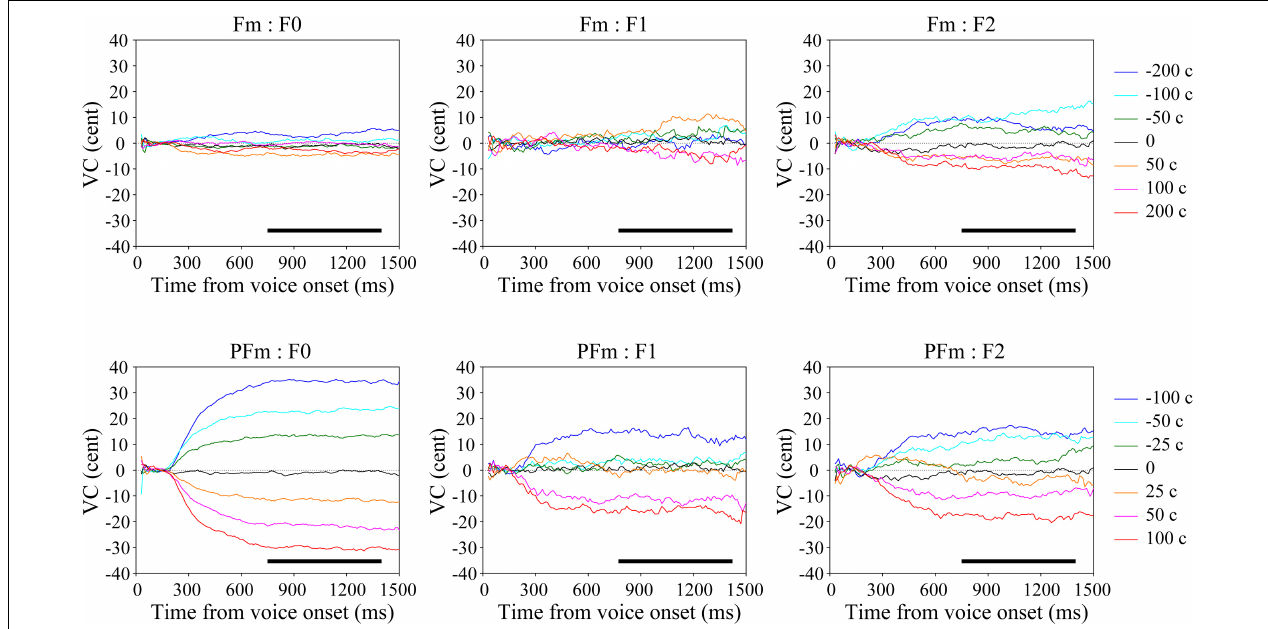
FIGURE 2 | The grand average voice change (VC) of continuous fundamental frequency (F0) and formants (F1–F2) in both types of AF modification conditions. The upper panel shows the results in the formant modification (Fm) conditions and the lower panel shows those in the pitch + formant modification (PFm) conditions. Warm-colored lines represent the frequency-increased conditions and the cold-colored lines represent the frequency-decreased conditions. The black bars show the selected time window (750–1400 ms) with relatively stable vocal responses.